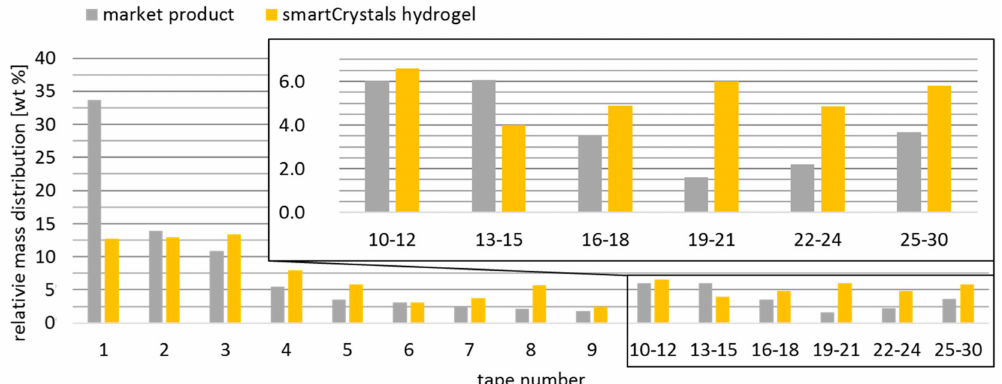
Figure 6. Penetration profiles measured on the inner forearm of one volunteer with healthy skin conditions via a tape stripping test after 20 min application of Symurban nanocrystal hydrogel (yellow bars) and a commercially available anti-pollution product (grey bars) with identical Symurban